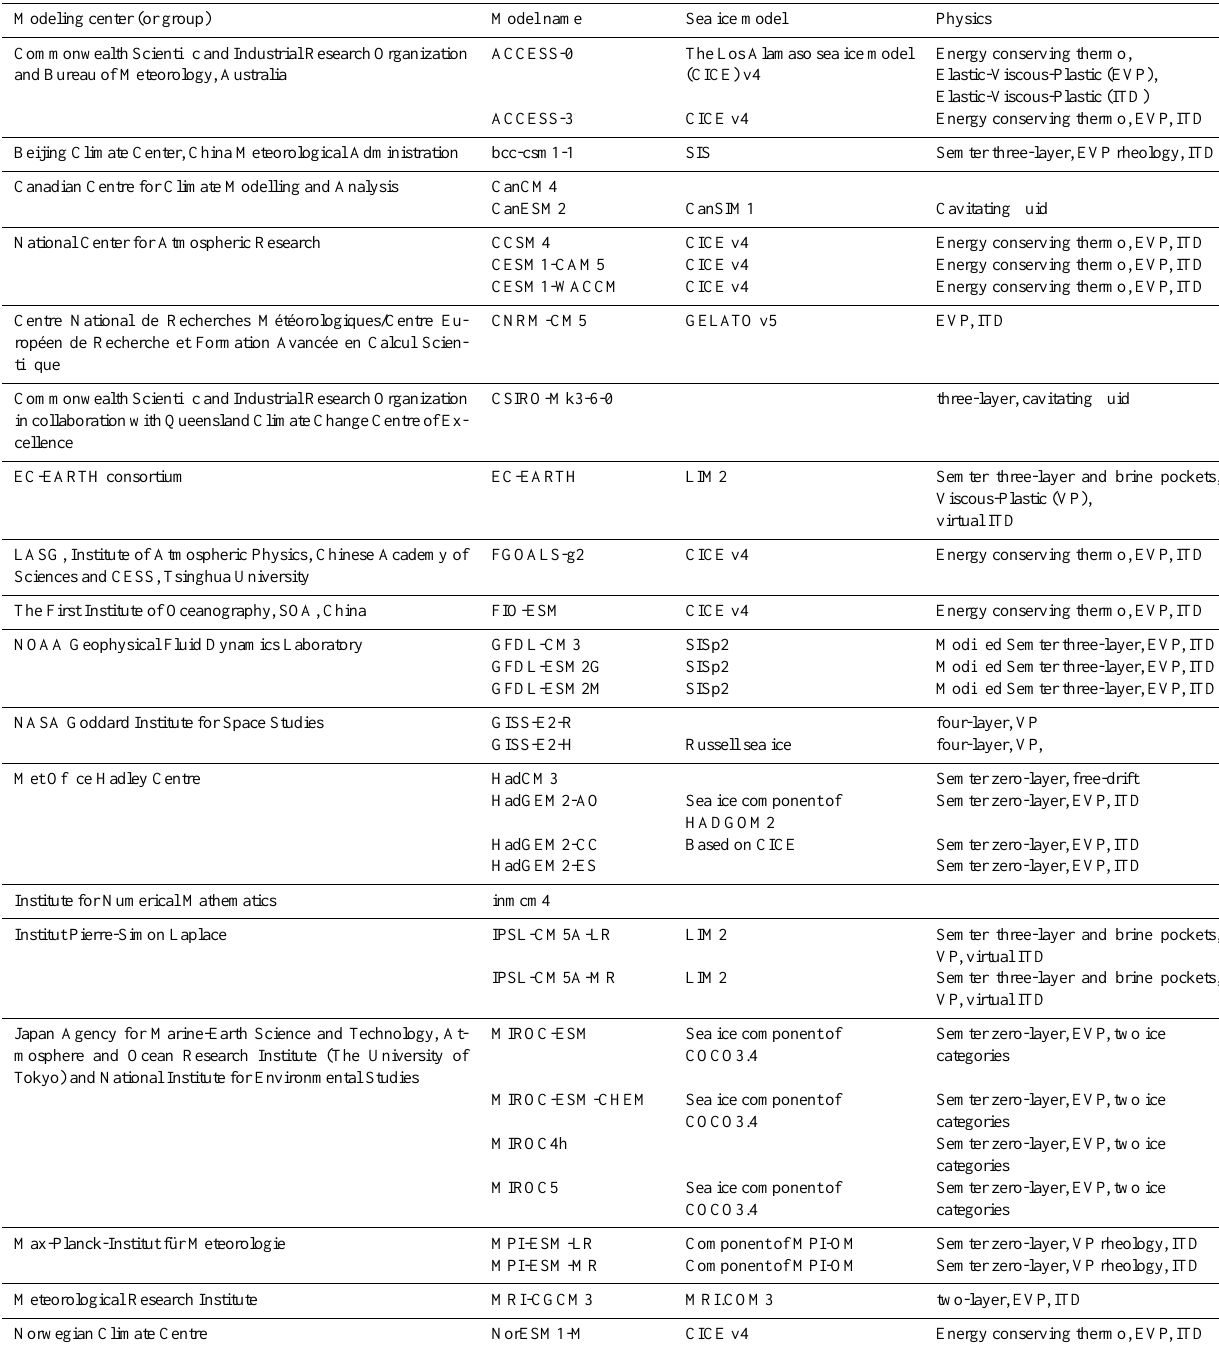
Table 1. Listing of models used in the analysis together with information on the sea ice model components and physics. For some models this information is not available in publications or on web